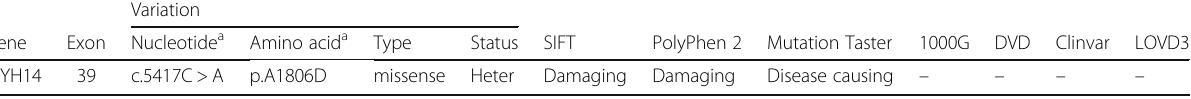
Table 2 Characteristics of the MYH14 variant, analysis of predicted protein structure and disease-causing effects Variation